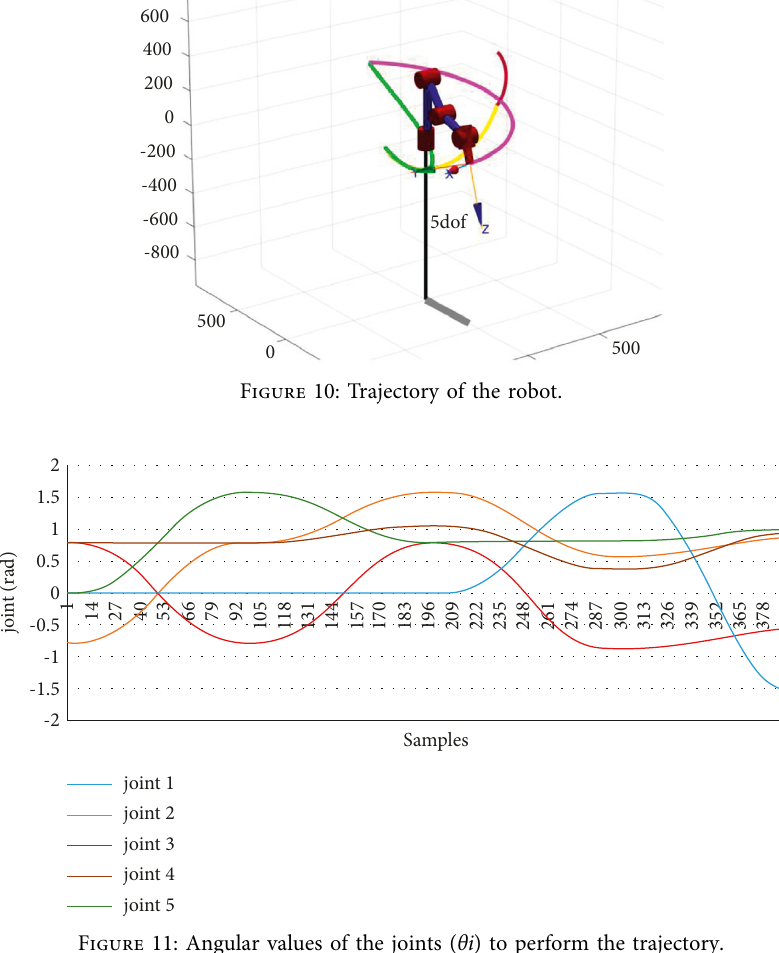
Figure 11: Angular values of the joints ( θi ) to perform the